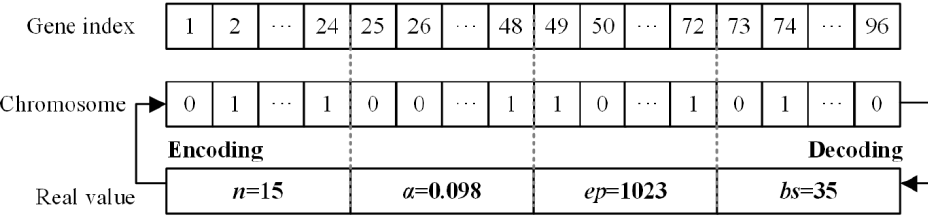
Figure 2. Encoding and decoding procedures.